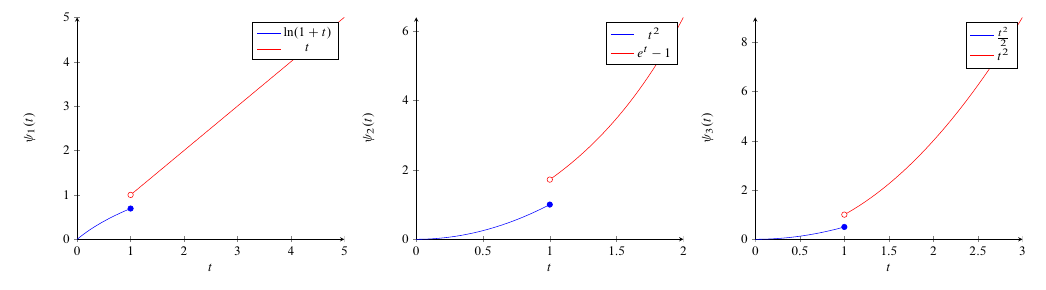
Fig. 2. Graphs of 1 ; 2 ; 3 in Example